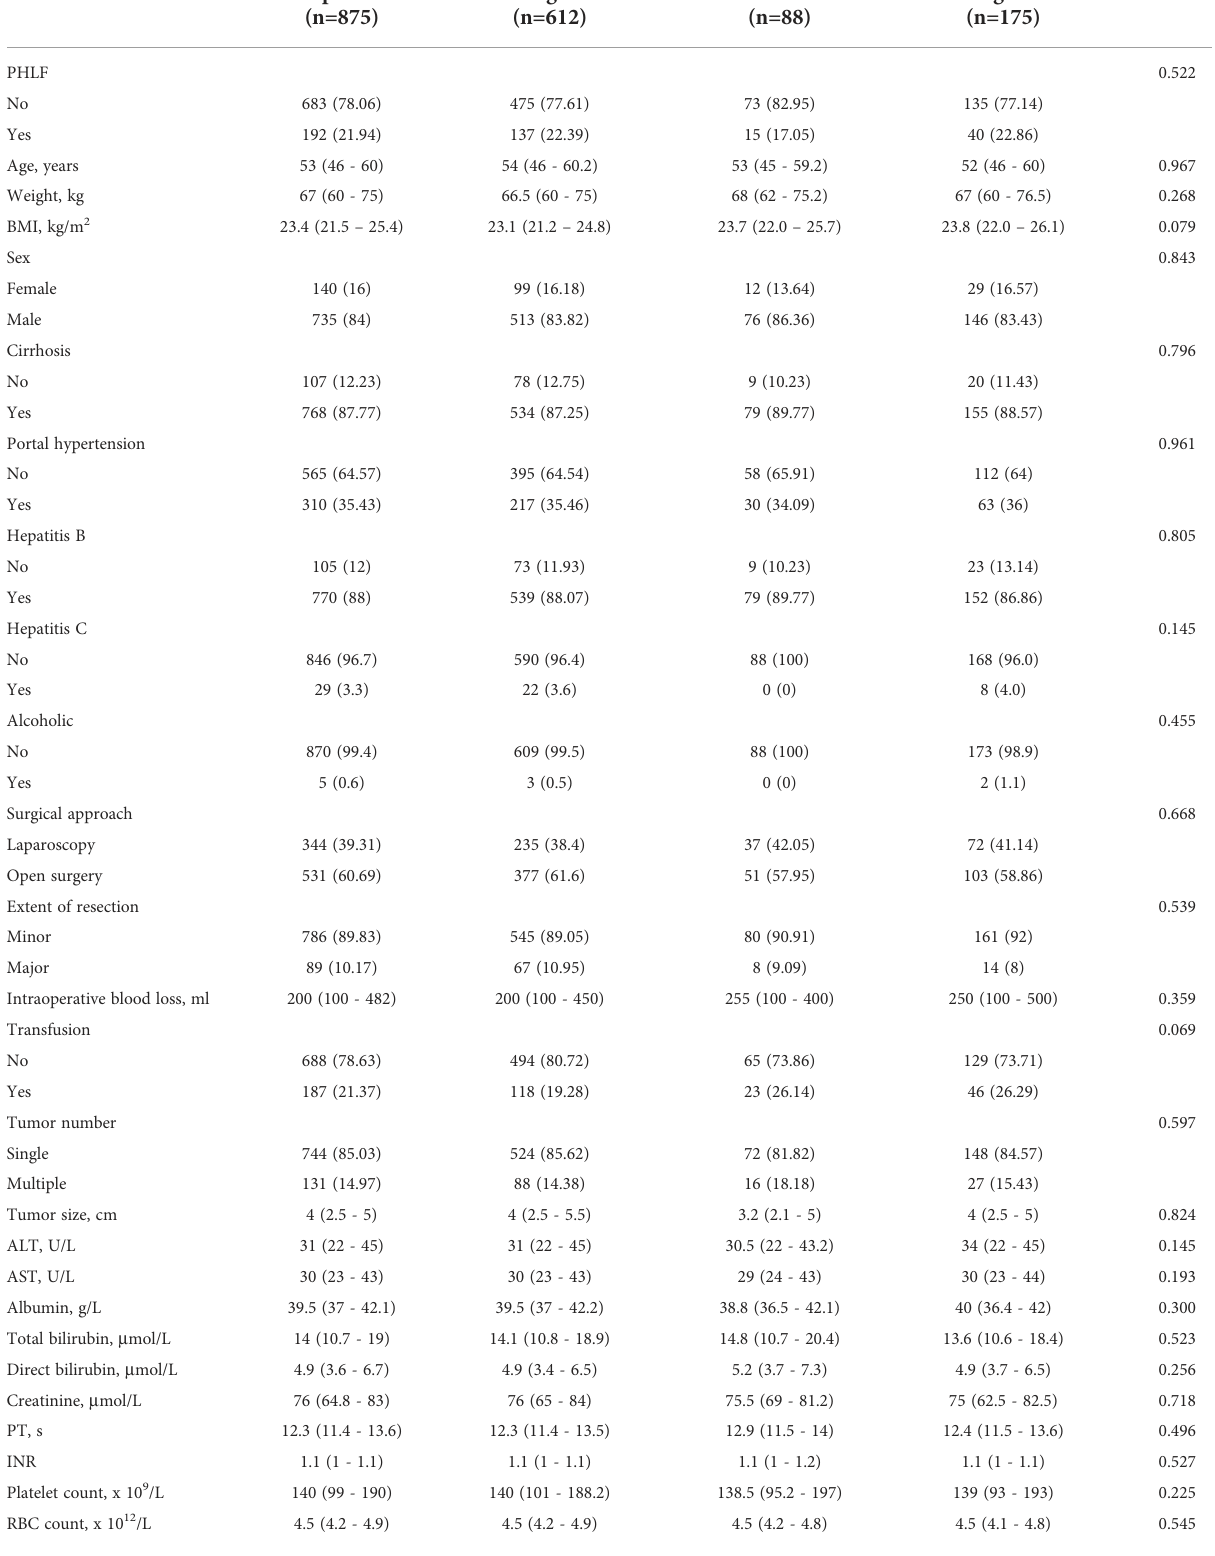
TABLE 1 Baseline